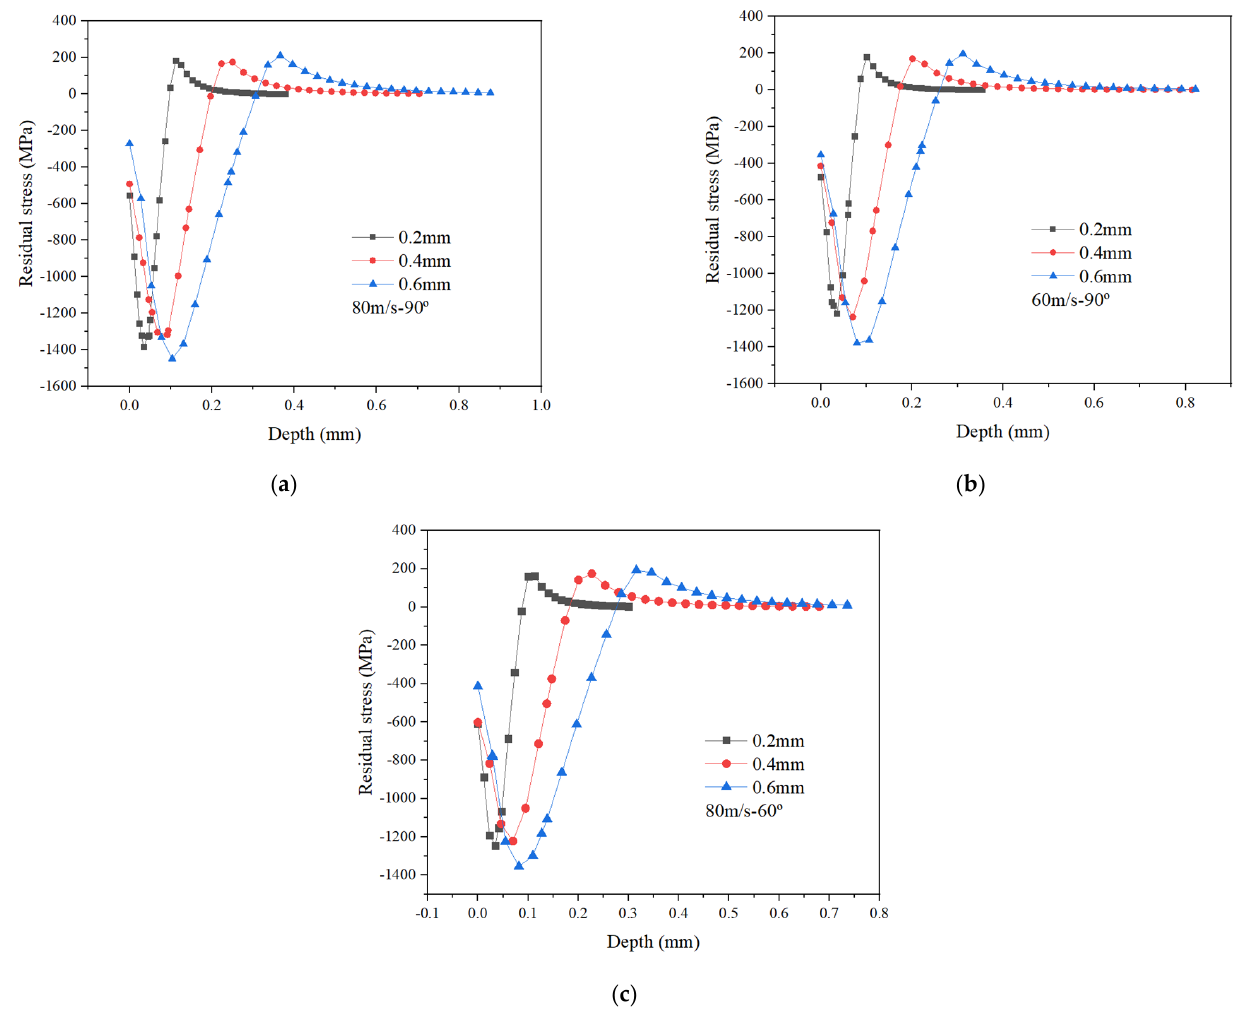
Figure 3. Effect of ball diameter on residual stress under different processing parameters. ( a ) v p = 80 m/s and α p = 90°; ( b ) v p = 60 m/s and α p = 90°; ( c ) v p = 80 m/s and α p = 60°.